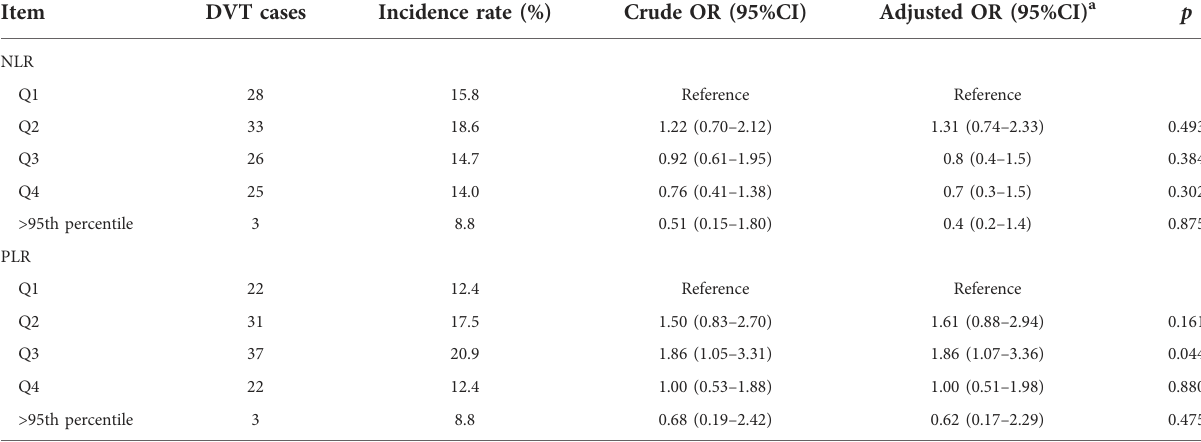
TABLE 3 Incidence rate of DVT following femoral neck fracture across the fi ve subgroups for NLR or PLR and the crude and adjusted ORs.